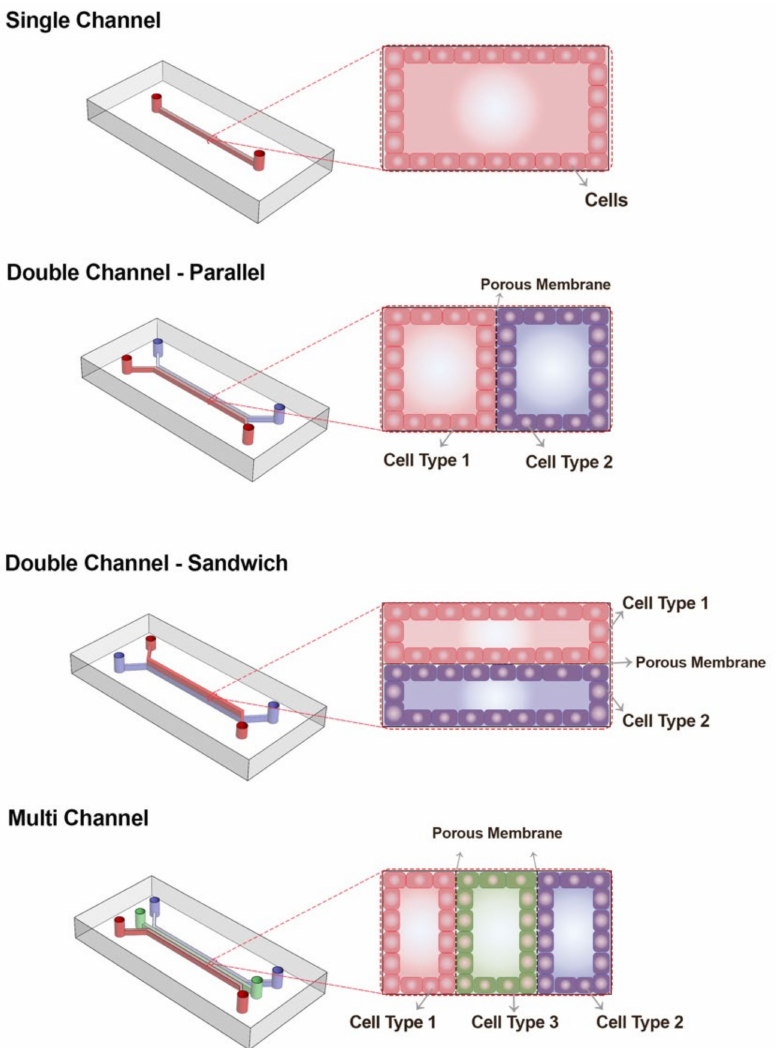
Figure 2. Schematic of an organ-on-chip with one, two, and multi channels. Usually there are three different layers of an OOC: bottom channel, porous membrane, and top